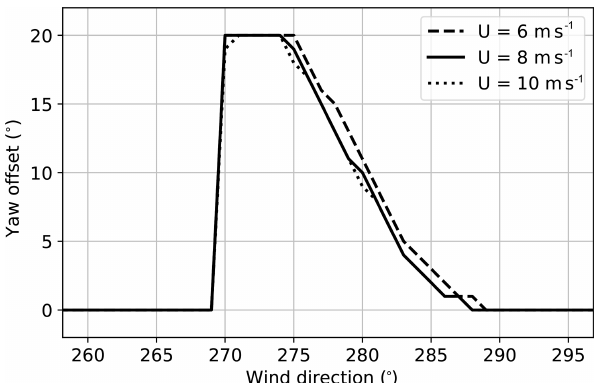
Figure 2. Yaw offset schedules optimized for a 5 D turbine spac- ing with static wind directions for mean wind speeds of 6, 8, and 10ms − 1